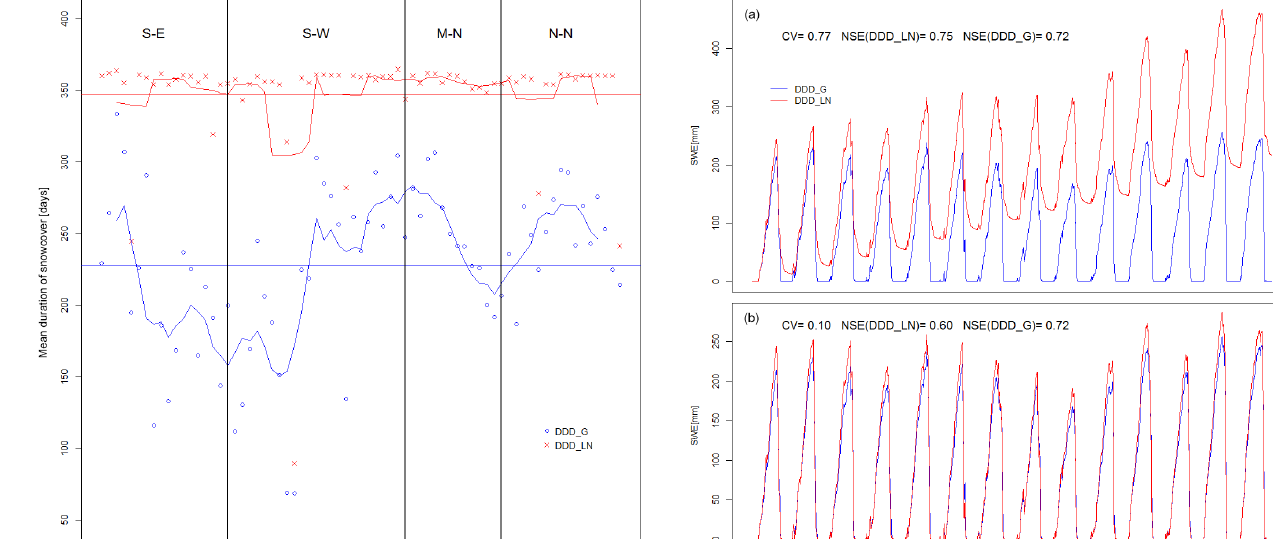
of DDD_LN is not correlated to any CC but to the parameter values of the method for spatial distribution of SWE, θ CV